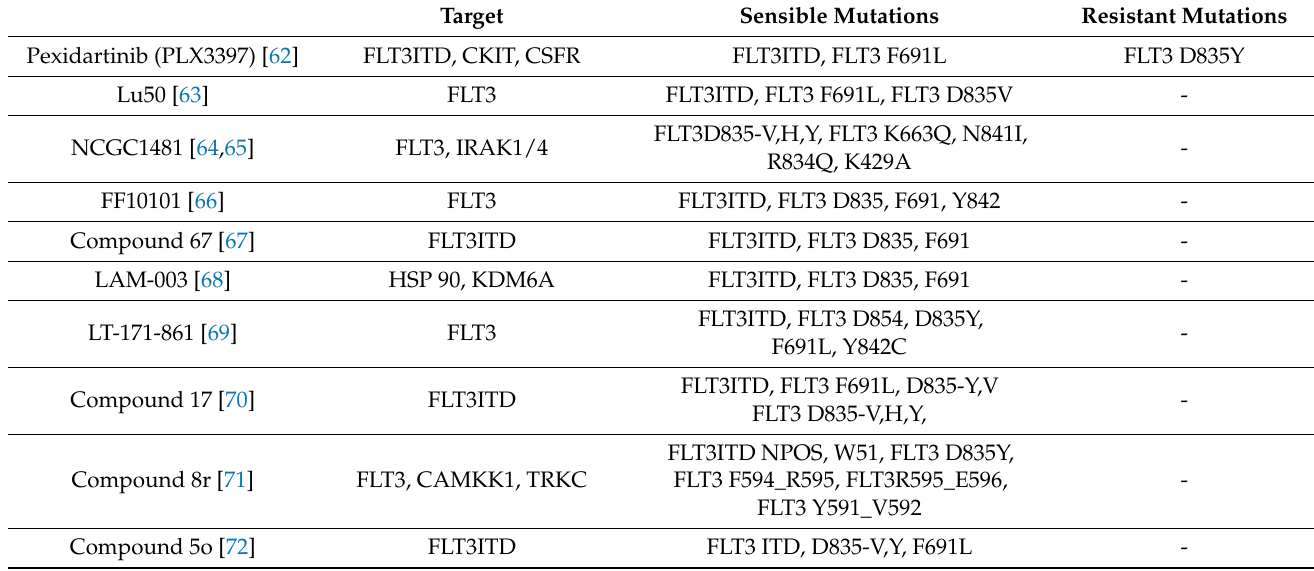
Table 3. List of new FLT3i identified in preclinical studies with sensitivities and resistance repertoire. Target Sensible Mutations Resistant